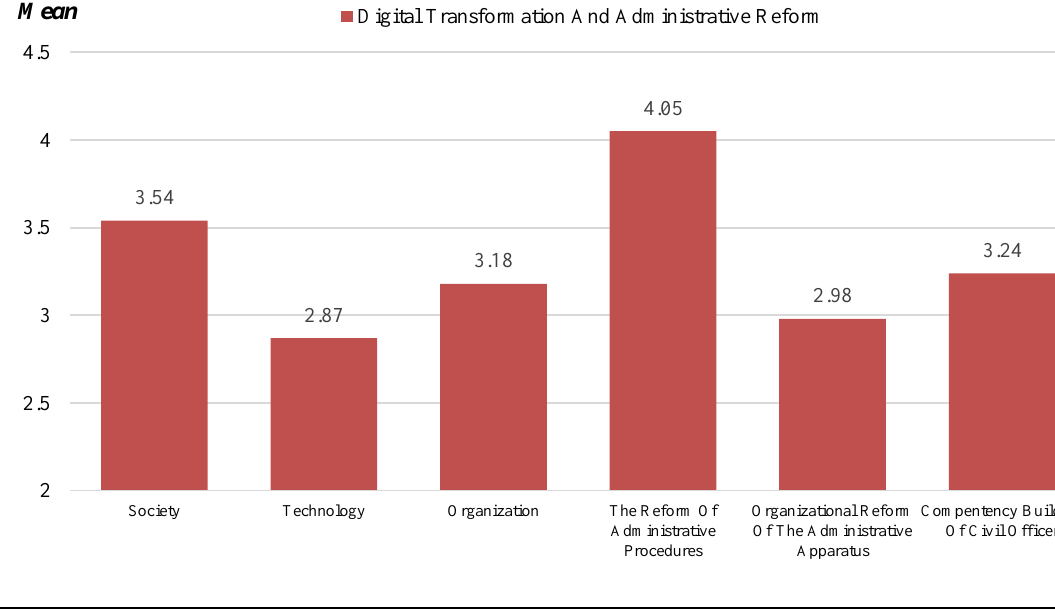
Figure 3. Digital transformation and administrative